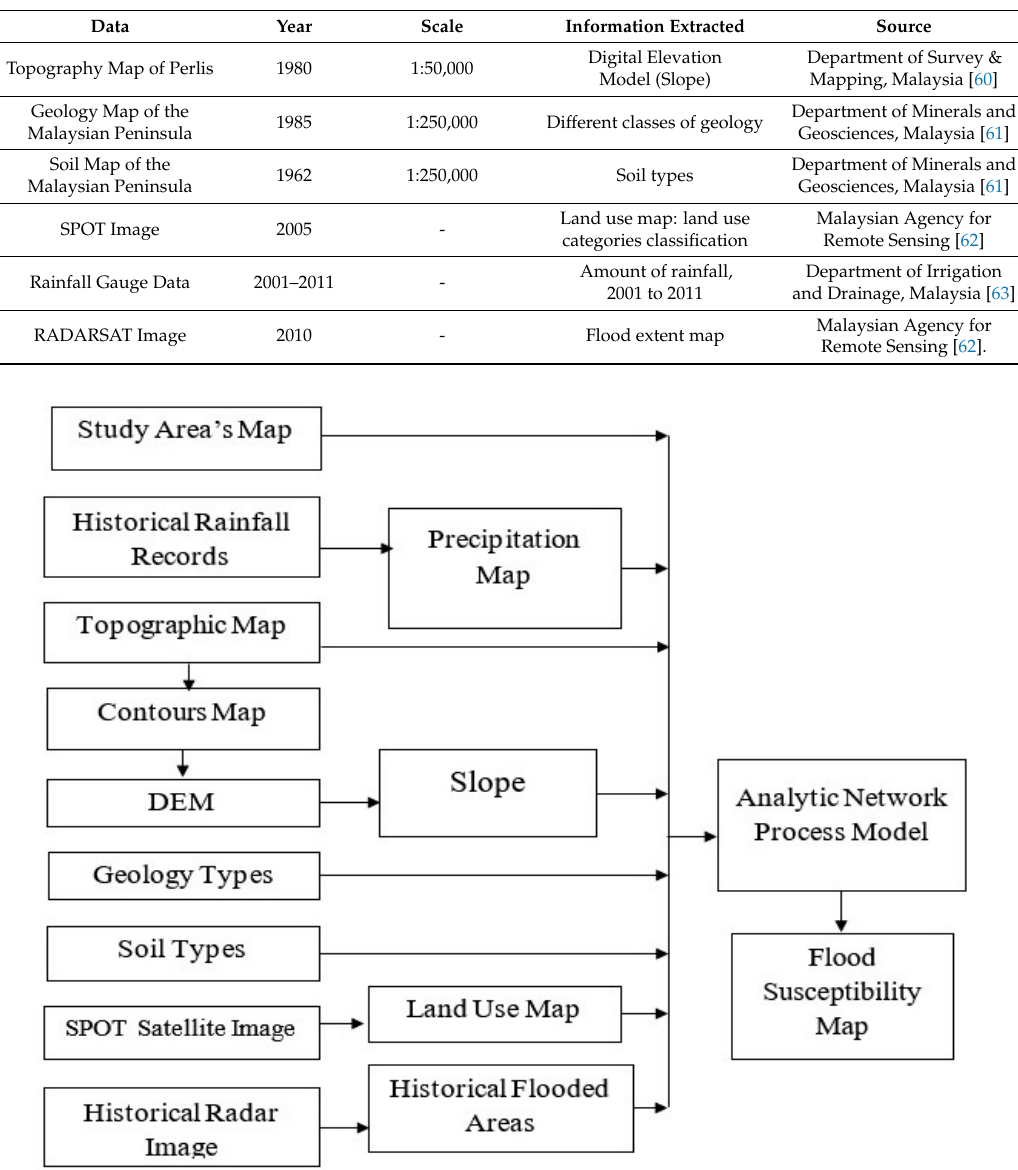
Table 4. Spatial data layers used in the study area.